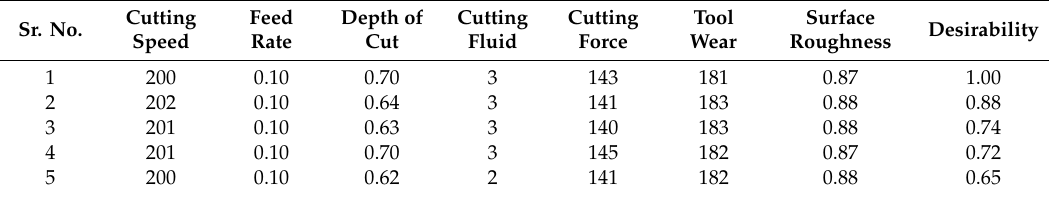
Table 6. Optimum results using composite desirability approach (CDA).